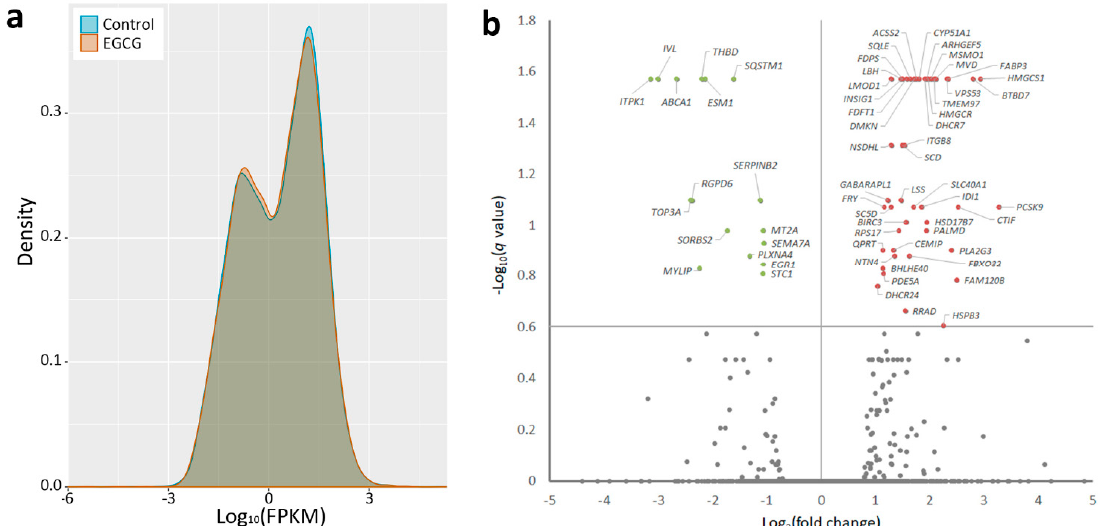
Figure 1. Differential gene expression patterns between idiopathic pulmonary fibrosis (IPF) fibroblasts treated with epigallocatechin gallate (EGCG) or water (control). ( a ) The frequency distribution of fragments per kilobase of transcript per million mapped reads (FPKM) between fibroblasts treated with EGCG or water (control) was compared and are presented in the density plot. ( b ) The volcano plot of –log 10 ( q -value) versus log 2 (fold change) showed differentially downregulated (left upper quadrant) and upregulated (right upper quadrant) genes expressed in EGCG-treated IPF fibroblasts versus water-treated IPF fibroblasts. The genes with q -values > 0.25 and > 2-fold changes are plotted in green (downregulated) or red (upregulated).